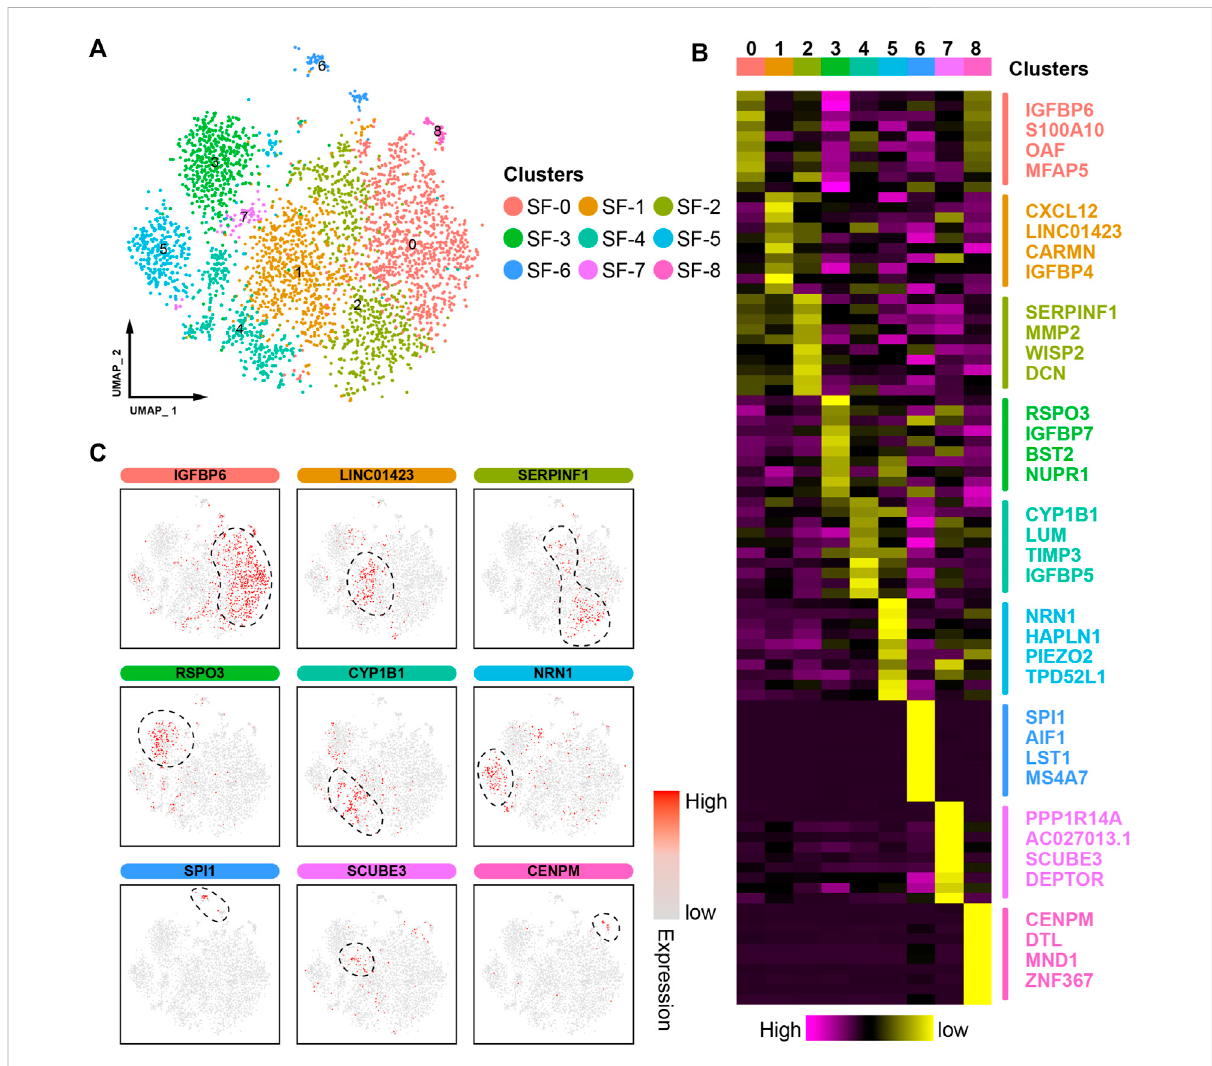
FIGURE 2 ScRNA-seq pro fi ling of synovitis microenvironments. (A) A uniform manifold approximation and projection (UMAP) plot showing the color- coded cell clusters in the synovitis microenvironment. (B) Heatmap showing the marker gene expression in the different cell clusters. (C) UMAP plot showing the marker gene expression in the different cell